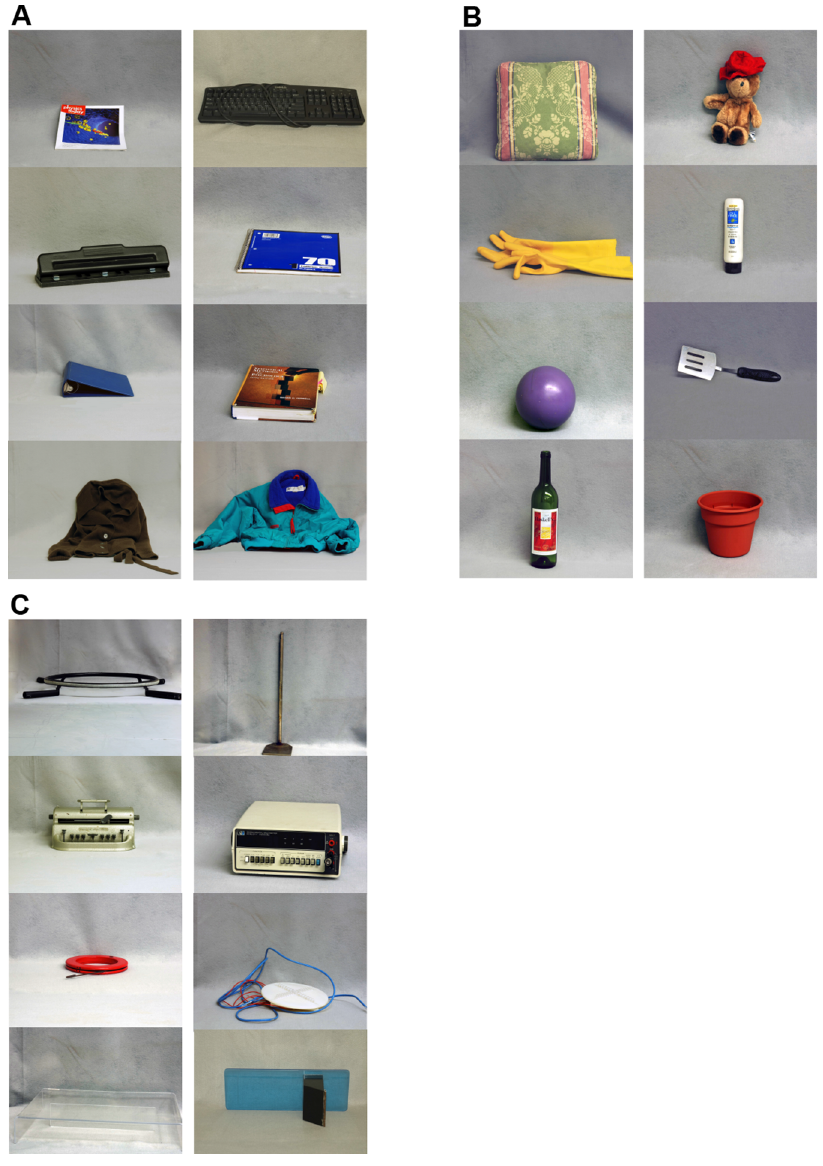
Figure 1. All objects used in the main experiment. (A) typical objects; (B) atypical objects; (C) unfamiliar objects. Left panel contains Set A objects; right panel contains Set B objects.